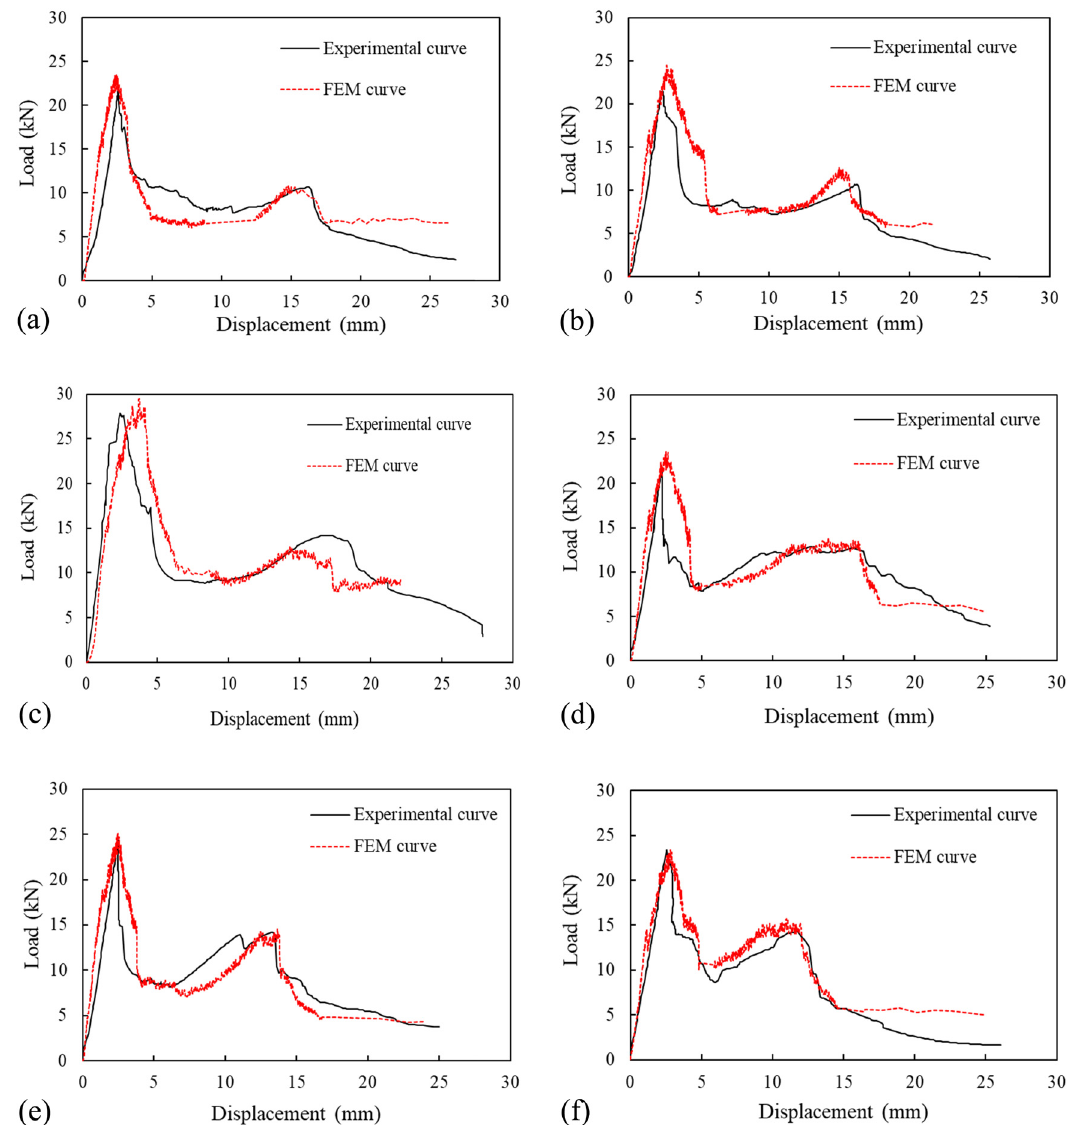
Figure 10: Comparison of simulated and experimental load – displacement curves. ( a ) F41D25, ( b ) F41D30, ( c ) F61D30, ( d ) F41D30w2, ( e ) F41D30w4, ( f )